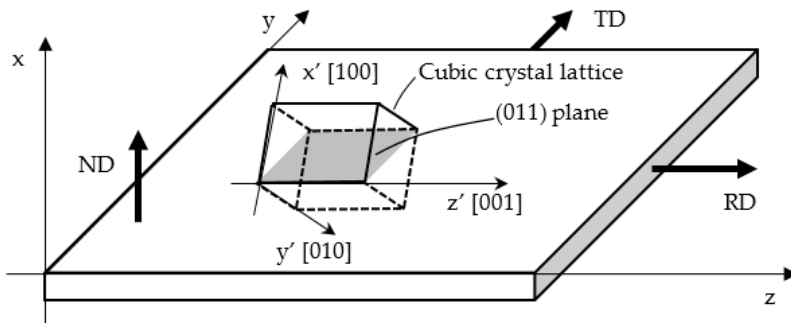
Figure 1. Crystal orientation of FeSi steel sheet with Goss texture corresponding to the Miller indices (110)[001].